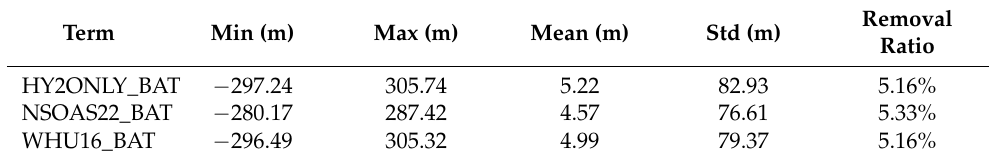
Table 3. Precision statistics of bathymetry models errors by removing gross